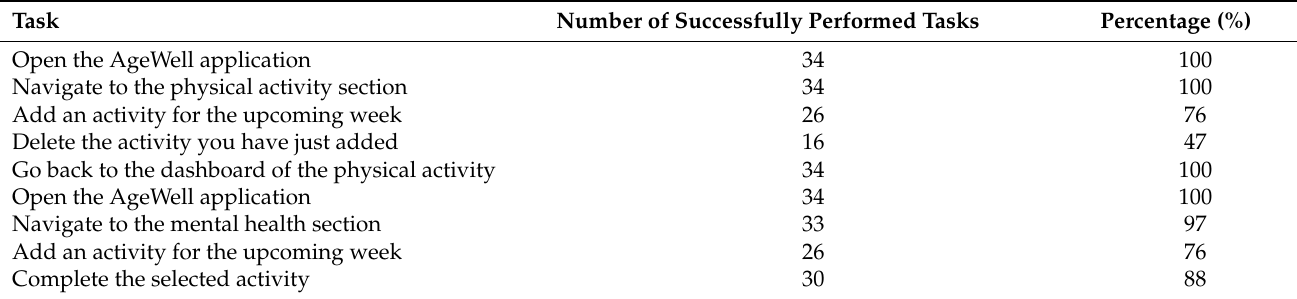
Table 7. Tasks to be completed ( n = 34).